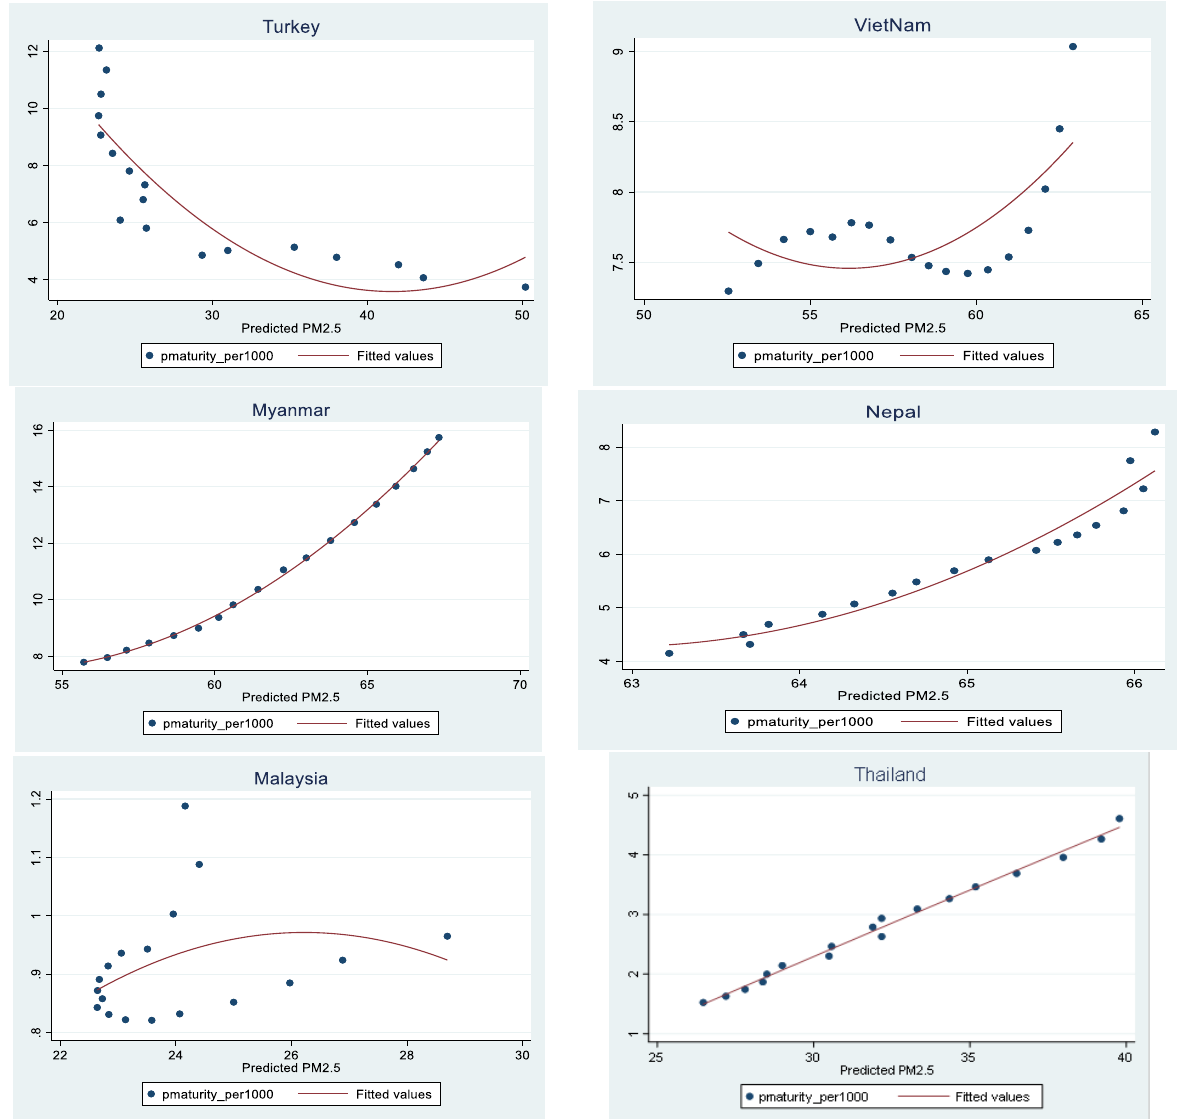
Figure A1. Predicted PM 2.5 effect on child mortality in Asian countries. Note: The above figures show the relationship between the predicted values of PM 2.5 and child mortality in each country. The y -axis represents child mortality while the x -axis represents predicted PM 2.5. The values of predicted PM 2.5 are obtained through regressing PM 2.5 on income, and the square of income. The upward-trending quadratic fitted line in most of the sampled countries is consistent with our aggregate second-stage results shown in Table 3, except for Turkey, Russia and Pakistan. We show this relationship in Figure A1 for all countries in our case. We observed that for most of the countries, our second-stage results are consistent, showing a positive effect of PM2.5 on child mortality. For some countries, this effect may not be observed in the Figures; however, as we use the conditional mean as the best linear unbiased estimator, any differences observed in individual countries do not falsify the inference inferred on average. We additionally control for the idiosyncratic behaviors of countries by using the country fixed effect in our estimation.